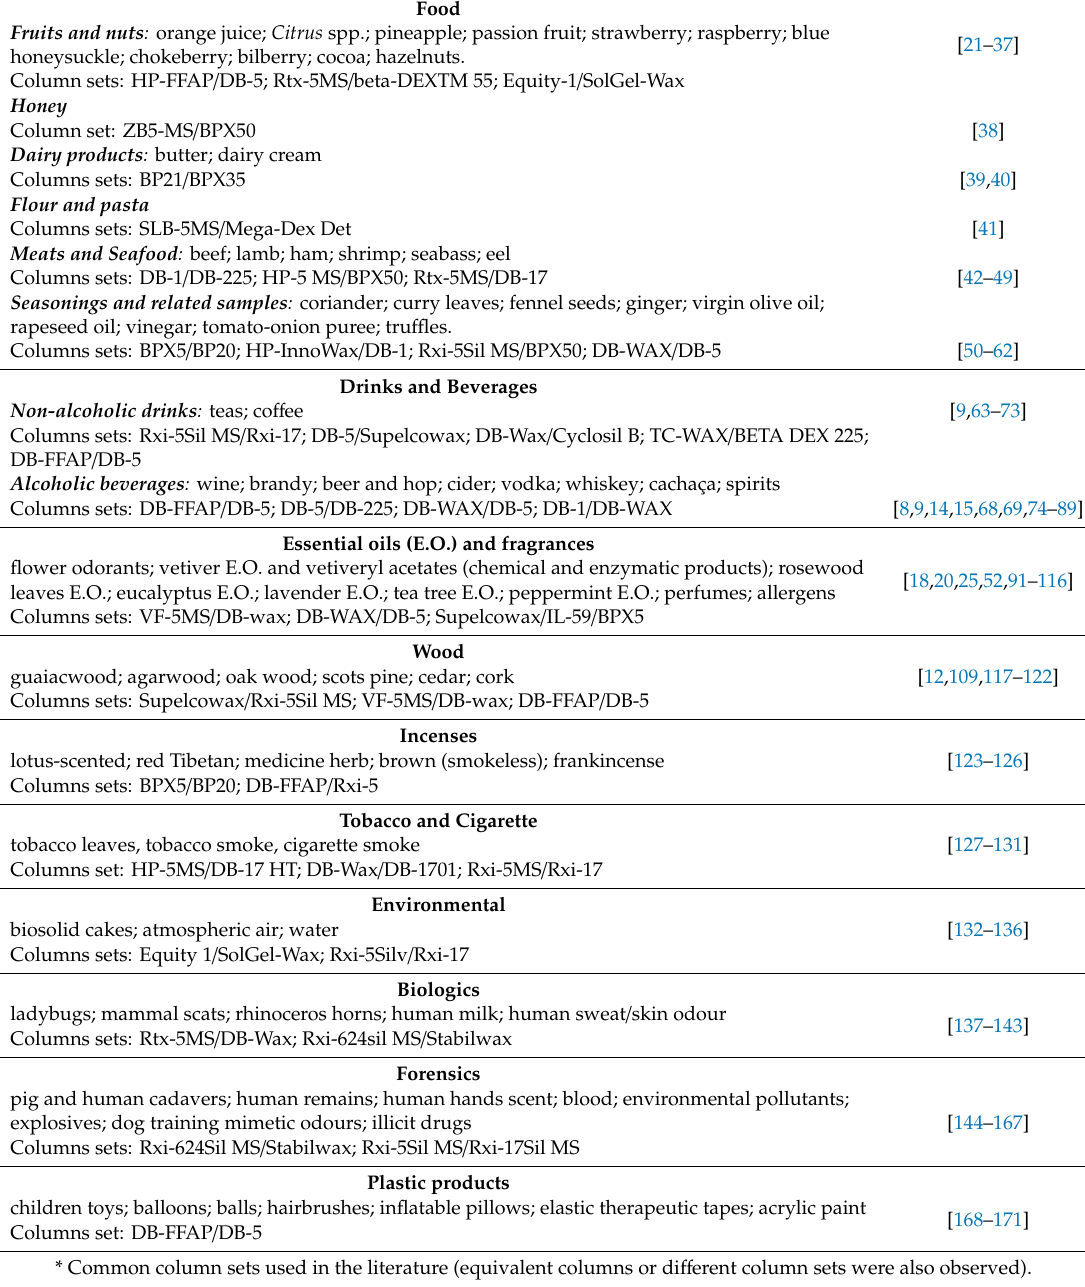
Table 2. Summary of the applications of MDGC and GC × GC in aroma analysis, referred to in this article. Samples / Column Sets